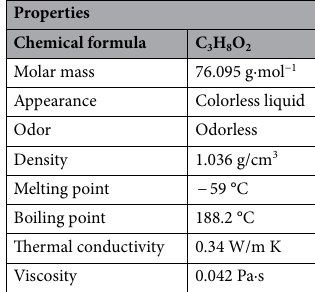
Table 1. Properties of propylene